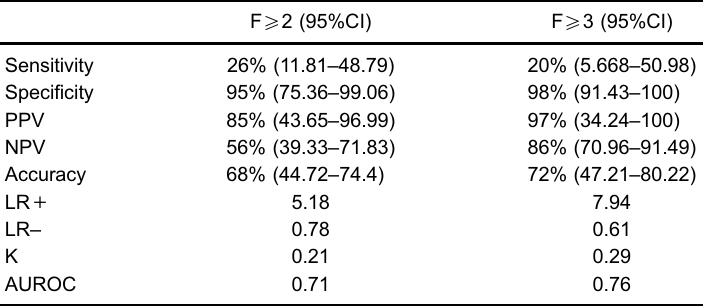
Table 2. Aspartate aminotransferase to platelet index (APRI) performance indicators for signi fi cant (F X 2) and advanced (F X 3) fi